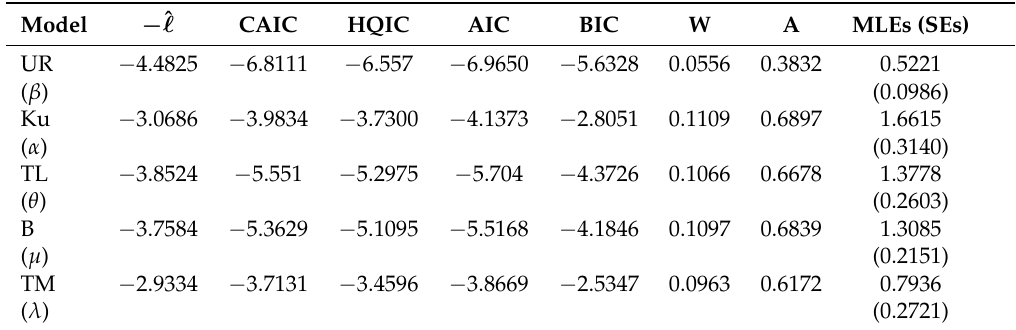
Table 2. Criteria and goodness-of-fit measures, maximum likelihood estimates (MLEs) and standard errors (SEs) for the times of infection data set.